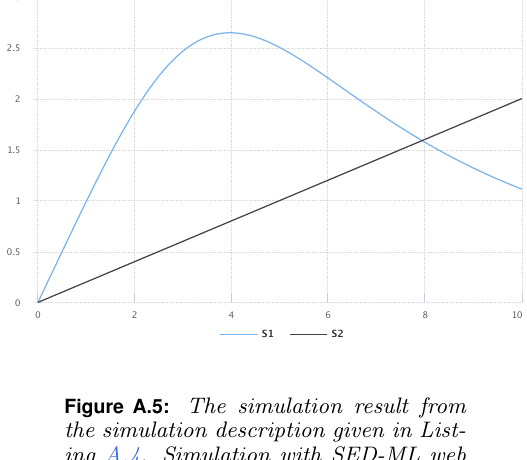
Figure A.6: Simulation with tellurium